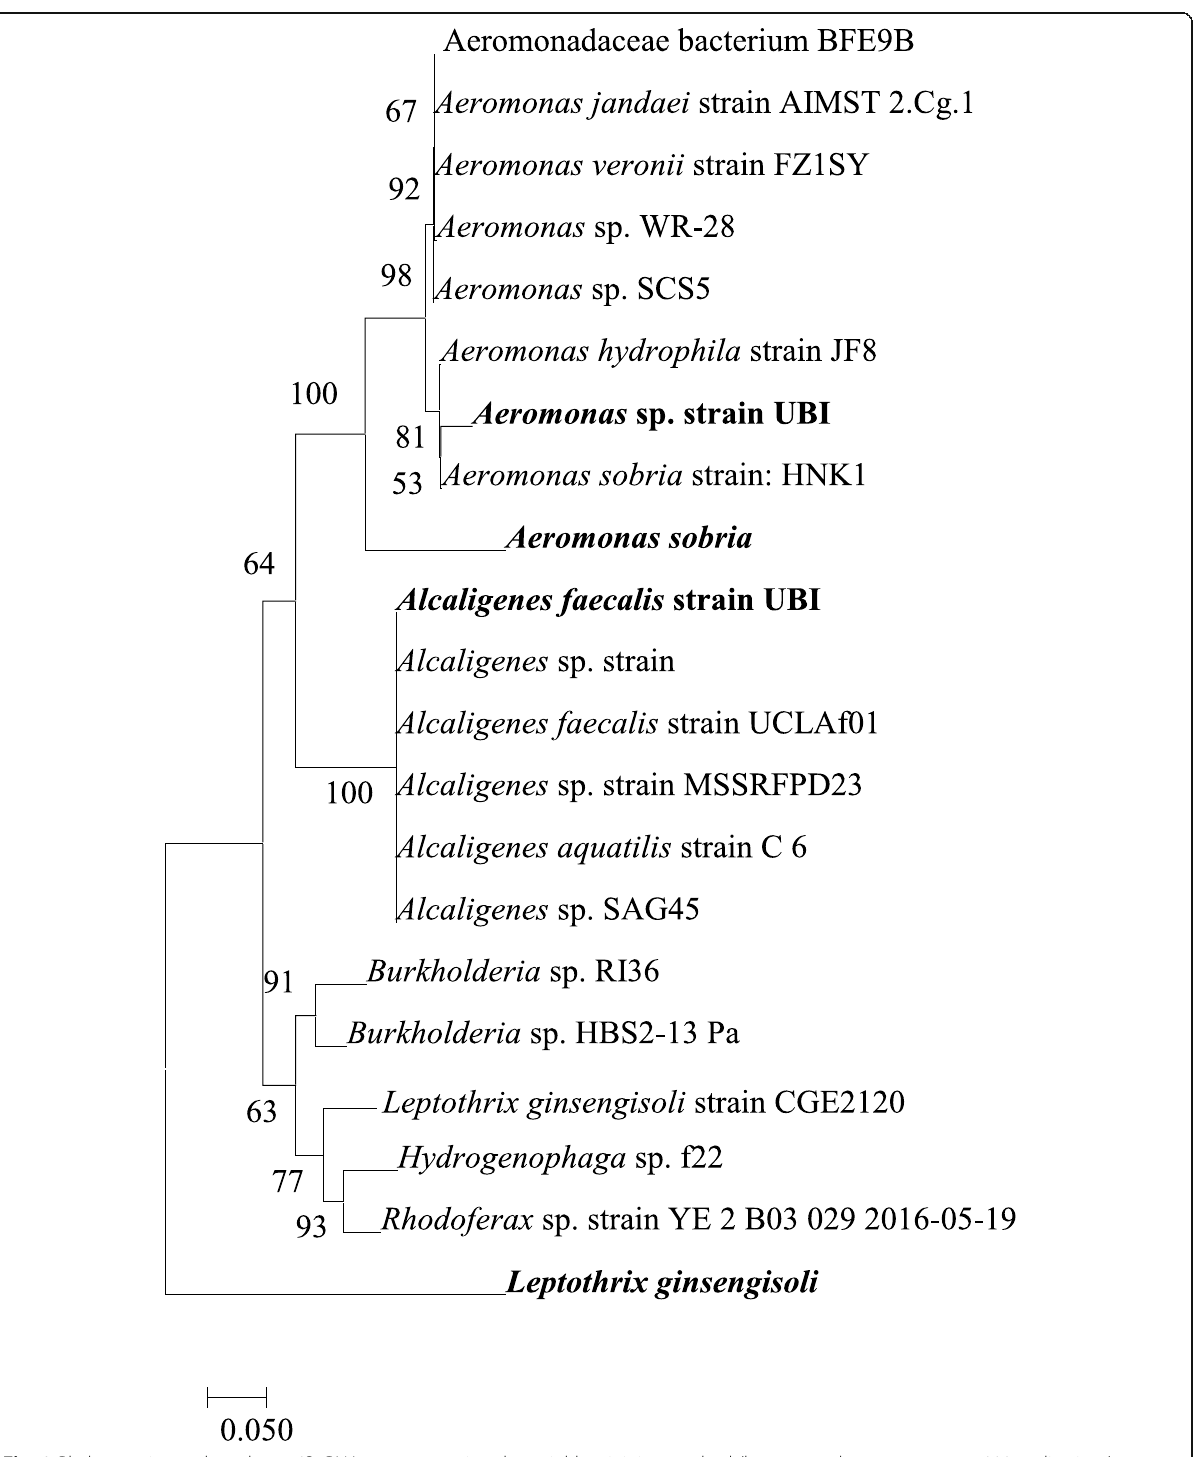
Fig. 9 Phylogenetic tree based on 16S rRNA sequence using the neighbor-joining method (bootsrap values were ran at 1000 replications) (isolates in bold are from this